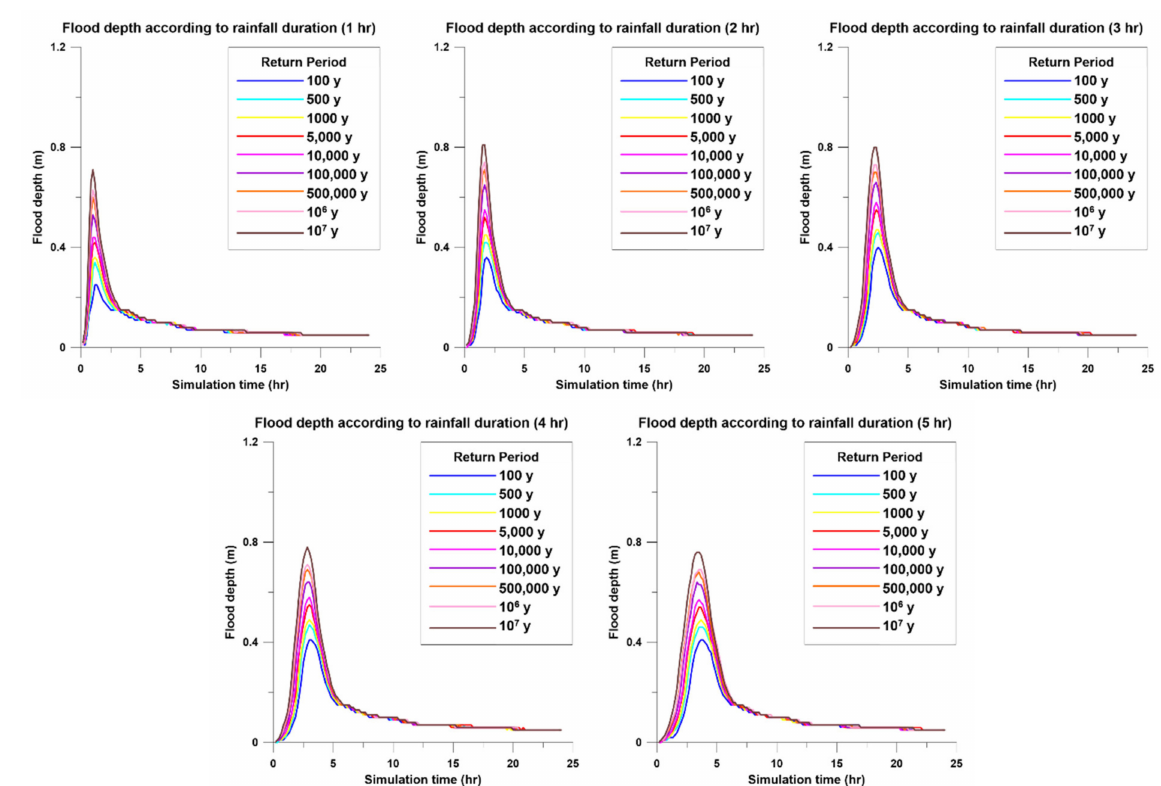
Figure 6. Inflow boundary conditions for grid no. 6989 (turbine building, NPP 2).